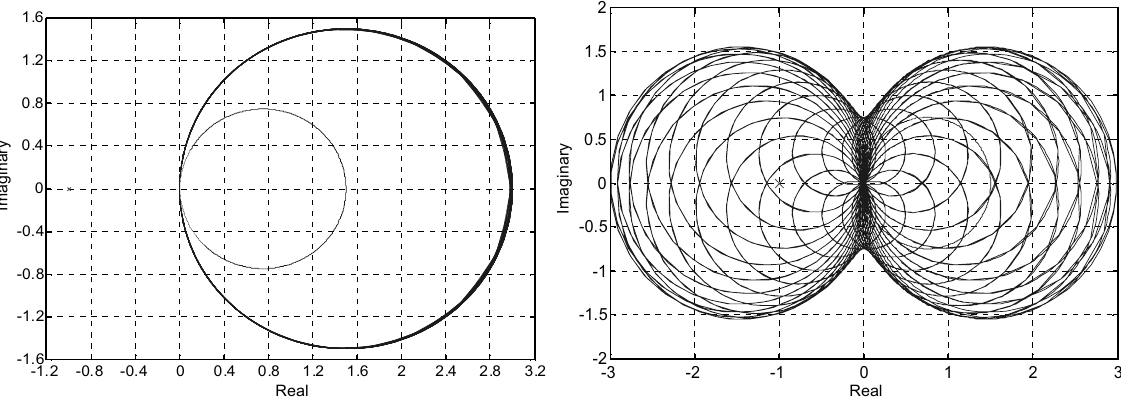
Fig. 5. Nyquist plot of the a system with with end dampers ( D 1 = D 2 = φ /4) and inertia at the load ( J 2 = 20 φτ ). Left – collocated, right – noncollocated ( β = 0.05).